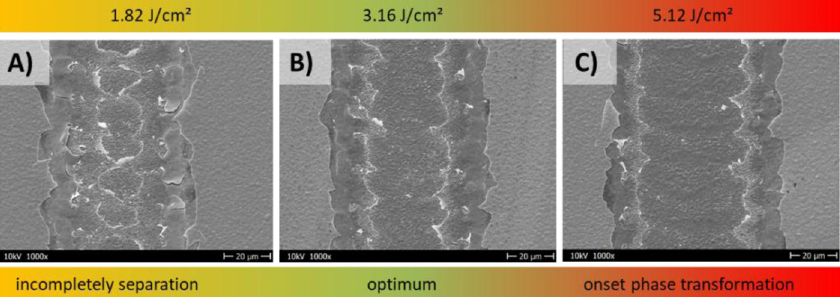
Fig. 11. Comparison of SEM images of P3 scribe lines, patterned with (A) 1.82 J/cm 2 , (B) 3.16J/cm 2 , (C) and 5.12J/cm 2 resulting in incomplete separation, optimal scribe line properties, and the onset of phase transformation of the underlying CIGSe absorber layer, respectively. The color bars above and below mark the optimal fl uences for patterning and summarize the substantial fi ndings, respectively. The magni fi cation the images is 1000 (cid:1) , the excitation voltage is 10 kV.